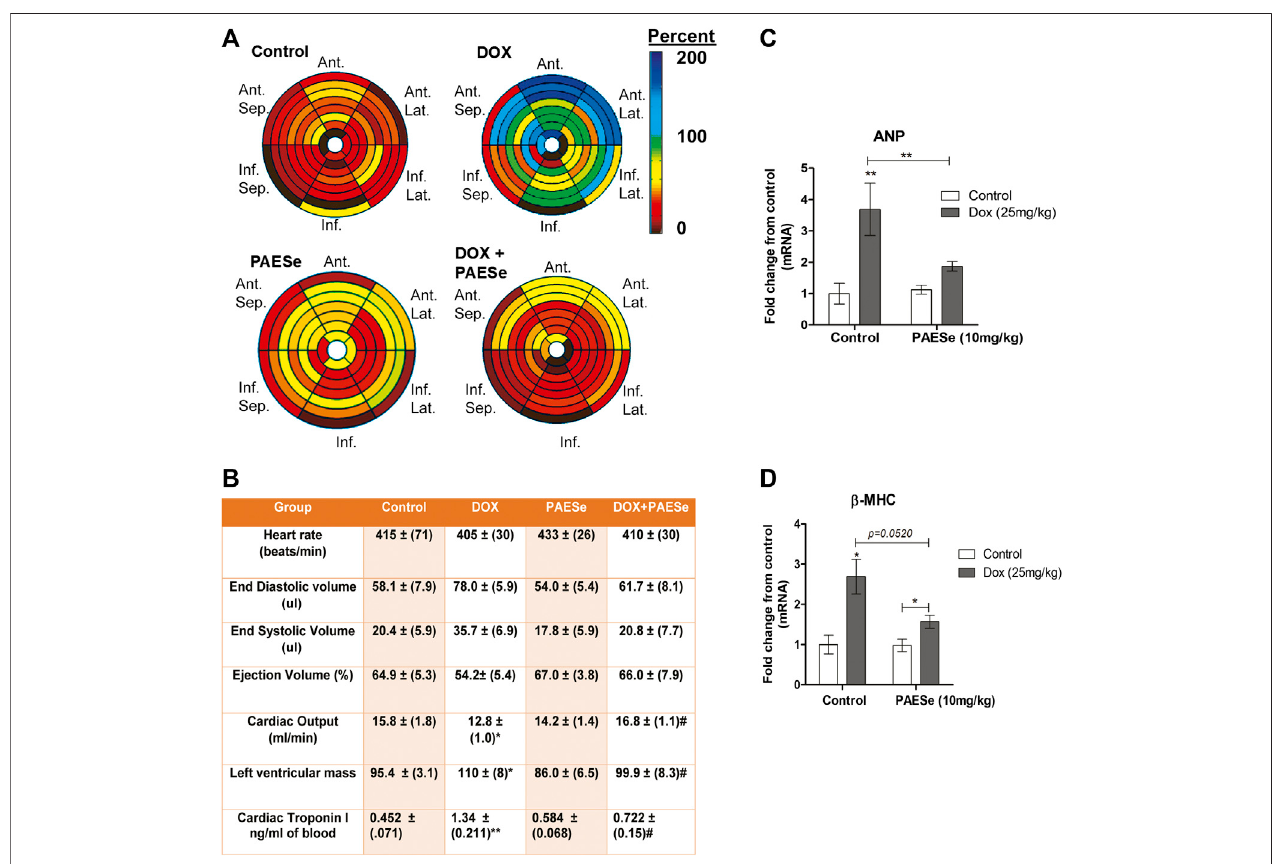
FIGURE 1 | PAESe protects against DOX-induced cardiac hypertrophy. (A,B) PAESe reduces DOX mediated changes in cardiac architecture and performance in athymic mice as determined from MRI analysis. 16 segment model of the LV portion of the Bull ’ s eye plot from MRI scans show the anterio-lateral geometry of the left ventricle (LV) in DOX treated mice (Ant, Anterior; sep, septum; Lat, Lateral; Inf, Inferior). Further MRI the analysis revealed an increase in left ventricular mass index, the effectsofDOXoncardiacperformancerevealedareducedend-diastolicvolumeandend-systolicvolume,aswellasreducedheartrate,ejectionvolumeandoverall cardiac output. Measurements of cardiac troponin (cTnI) from serum samples revealed the presences of cardiotoxicity and that PAEse offered cardioprotection against Dox mediated cardiotoxicity. (C,D) Measurements ofchanges inmarkers forcardiac hypertrophy (ANP and β -MHC) asmeasured by qRT-PCR analysisin athymic mice treated with Doxorubicin (DOX) (5 mg/kg, one dose per week for 5 weeks, 2 weeks recovery). Values were based on ΔΔ ct values, which were standardized to β -actin expression. Statistical differences were determined by a student t-test, and comparisons were analyzed based on SEM where n (cid:2) 4 animals per group. Values are represented as mean ± S.E.M. and were analyzed by student t-test where N (cid:2) 4 animals per group. *; p < 0.05. **; p <